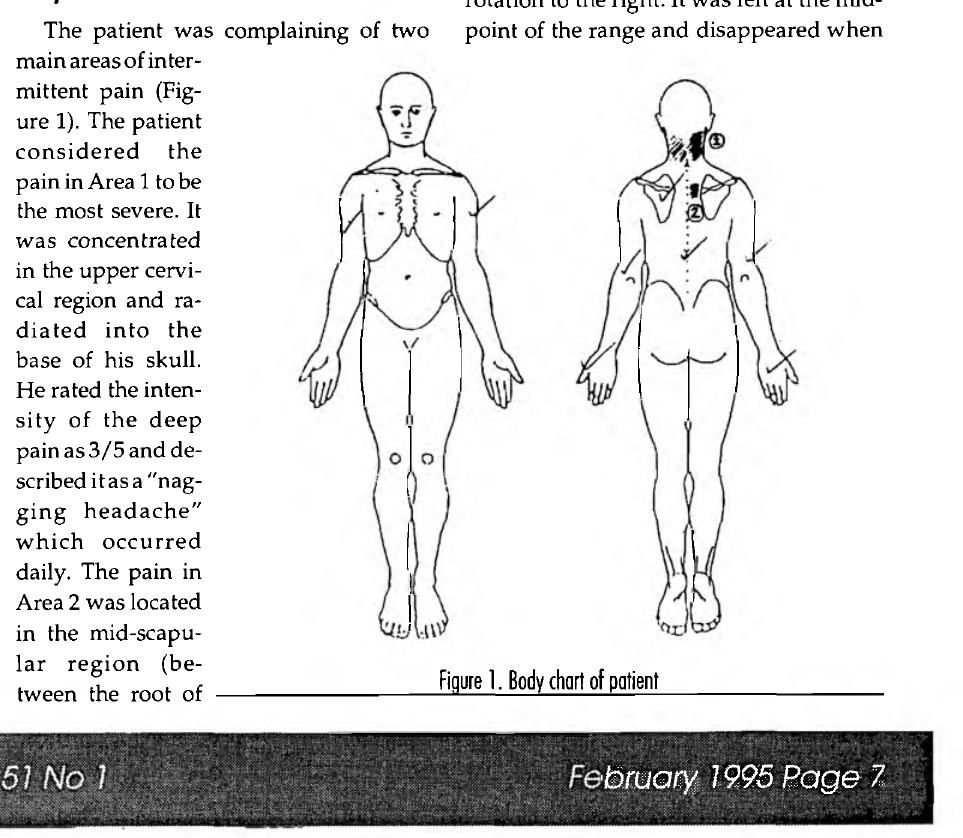
Figure 1. Body chart of